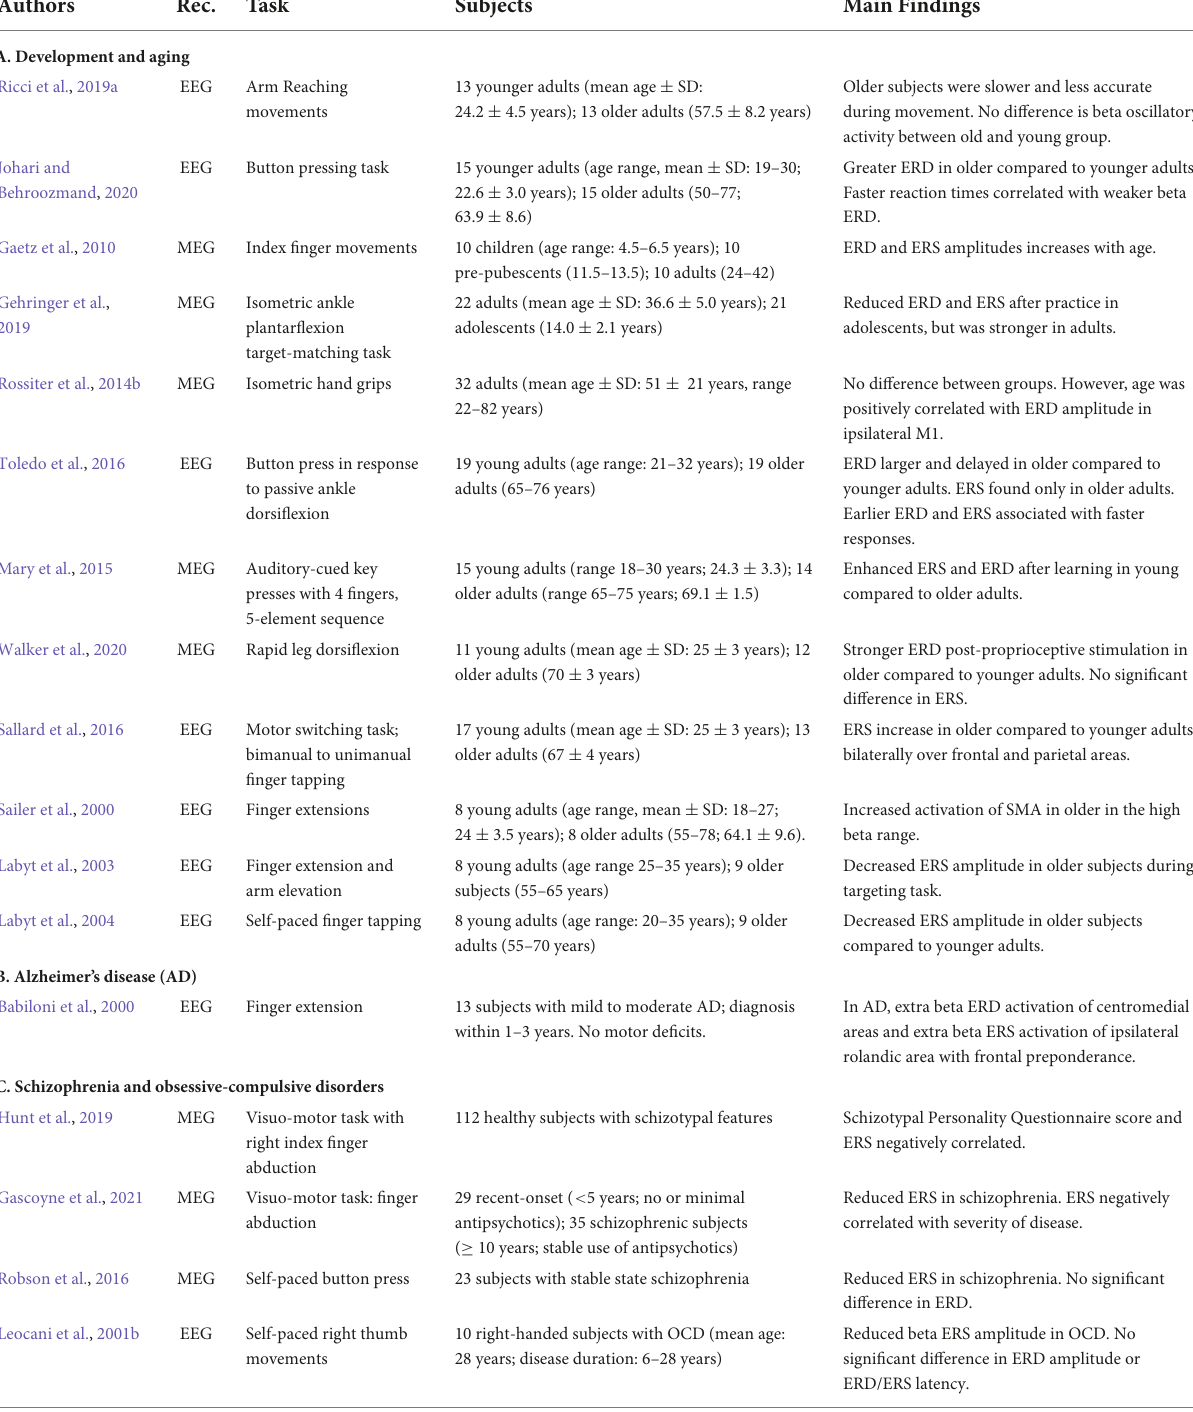
TABLE 4 Review of studies on movement-related beta ERD and ERS in development and aging, Alzheimer’s disease, and